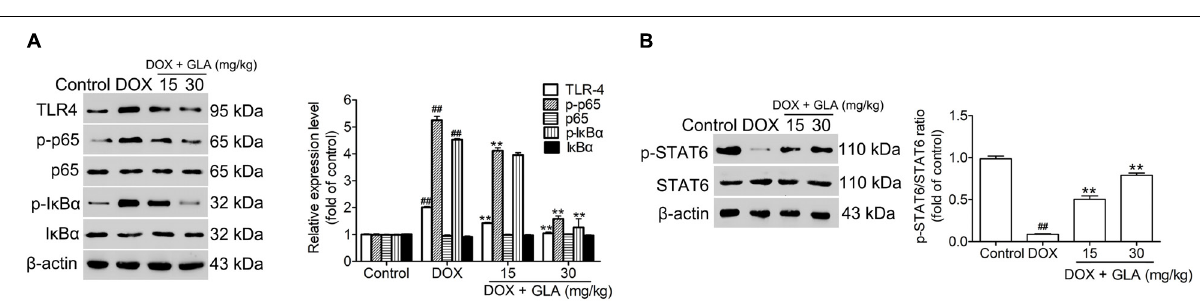
FIGURE 7 | Glabridin (GLA) prevents NF- κ B and STAT6 signaling in the colonic macrophage from the doxorubicin (DOX)-treated mice. A single dose of DOX (20 mg/kg) was intraperitoneally injected into the C57BL/6 mice to induce acute cardiotoxicity. GLA (15 and 30 mg/kg) or vehicle was intragastrically administered once daily for 12 days, starting 7 days before DOX injection. (A) TLR4, p65, p-p65, p-I κ B α , and I κ B α in the colonic tissues were determined by Western blot ( n = 10). (B) p-STAT6 and STAT6 in the colonic tissues were determined by Western blot ( n = 10). The values are presented as the mean ± SEM. # P < 0.05, ## P < 0.01 vs. control, ∗ P < 0.05, ∗∗ P < 0.01 vs.